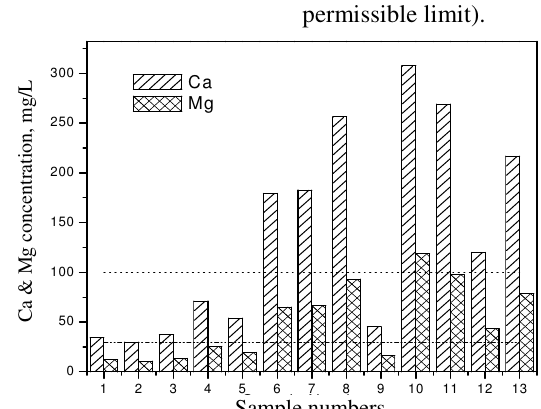
Figure 3. Chloride concentration in the water samples (Dotted line indicates the permissible limit).